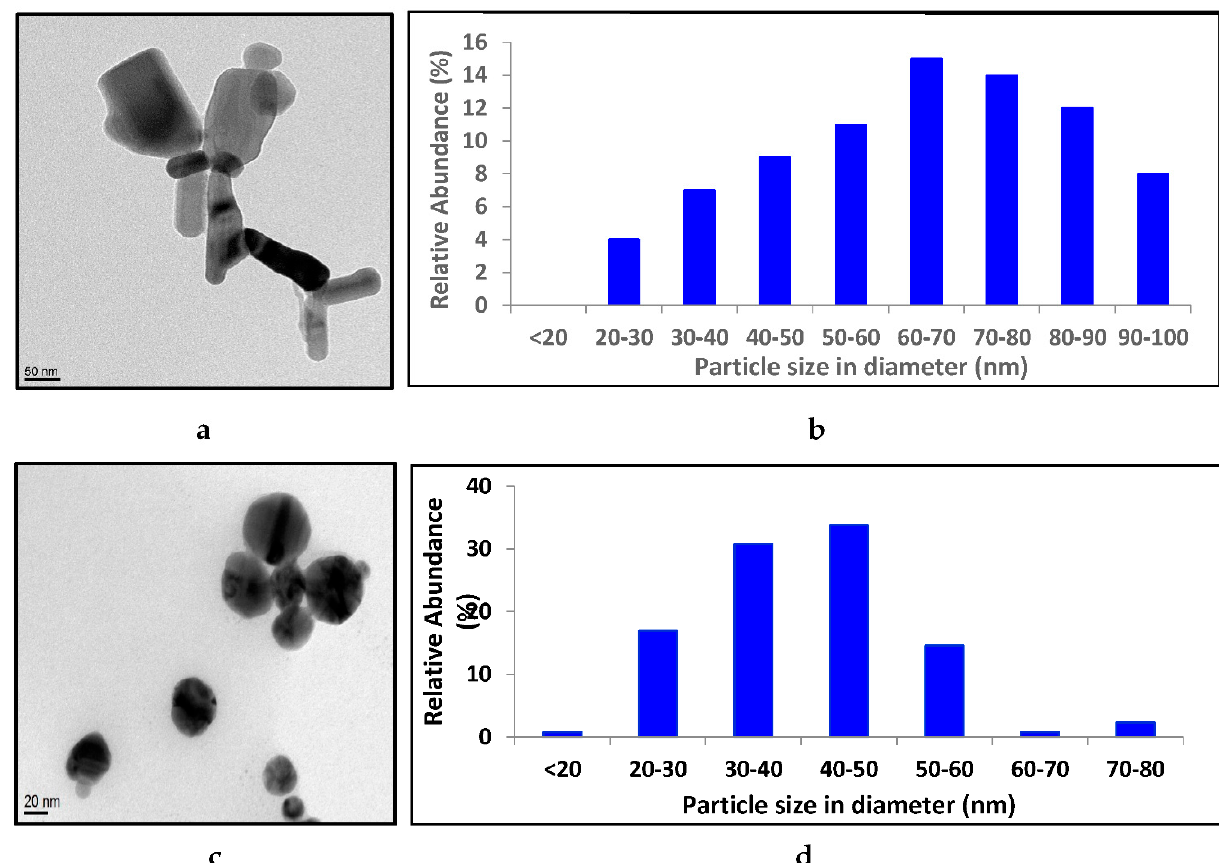
Figure 1. TEM image and size distribution of ZnO NPs ( a , b ) and TEM image and size distribution of Ag NPs ( c , d ).